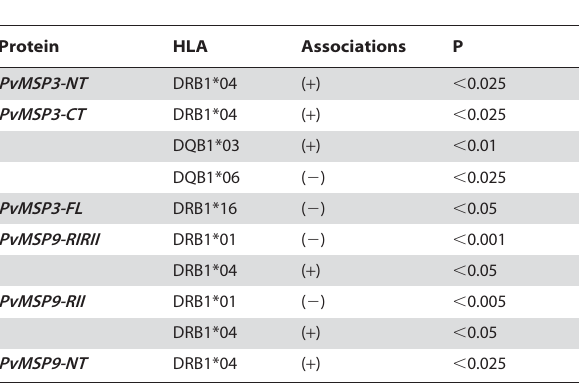
Table 4. Summary of associations between HLA-DRB1* allelic groups and the frequency of responders to PvMSP-1, PvMSP- 3 a and PvMSP-9 calculated by the bi-partition X 2